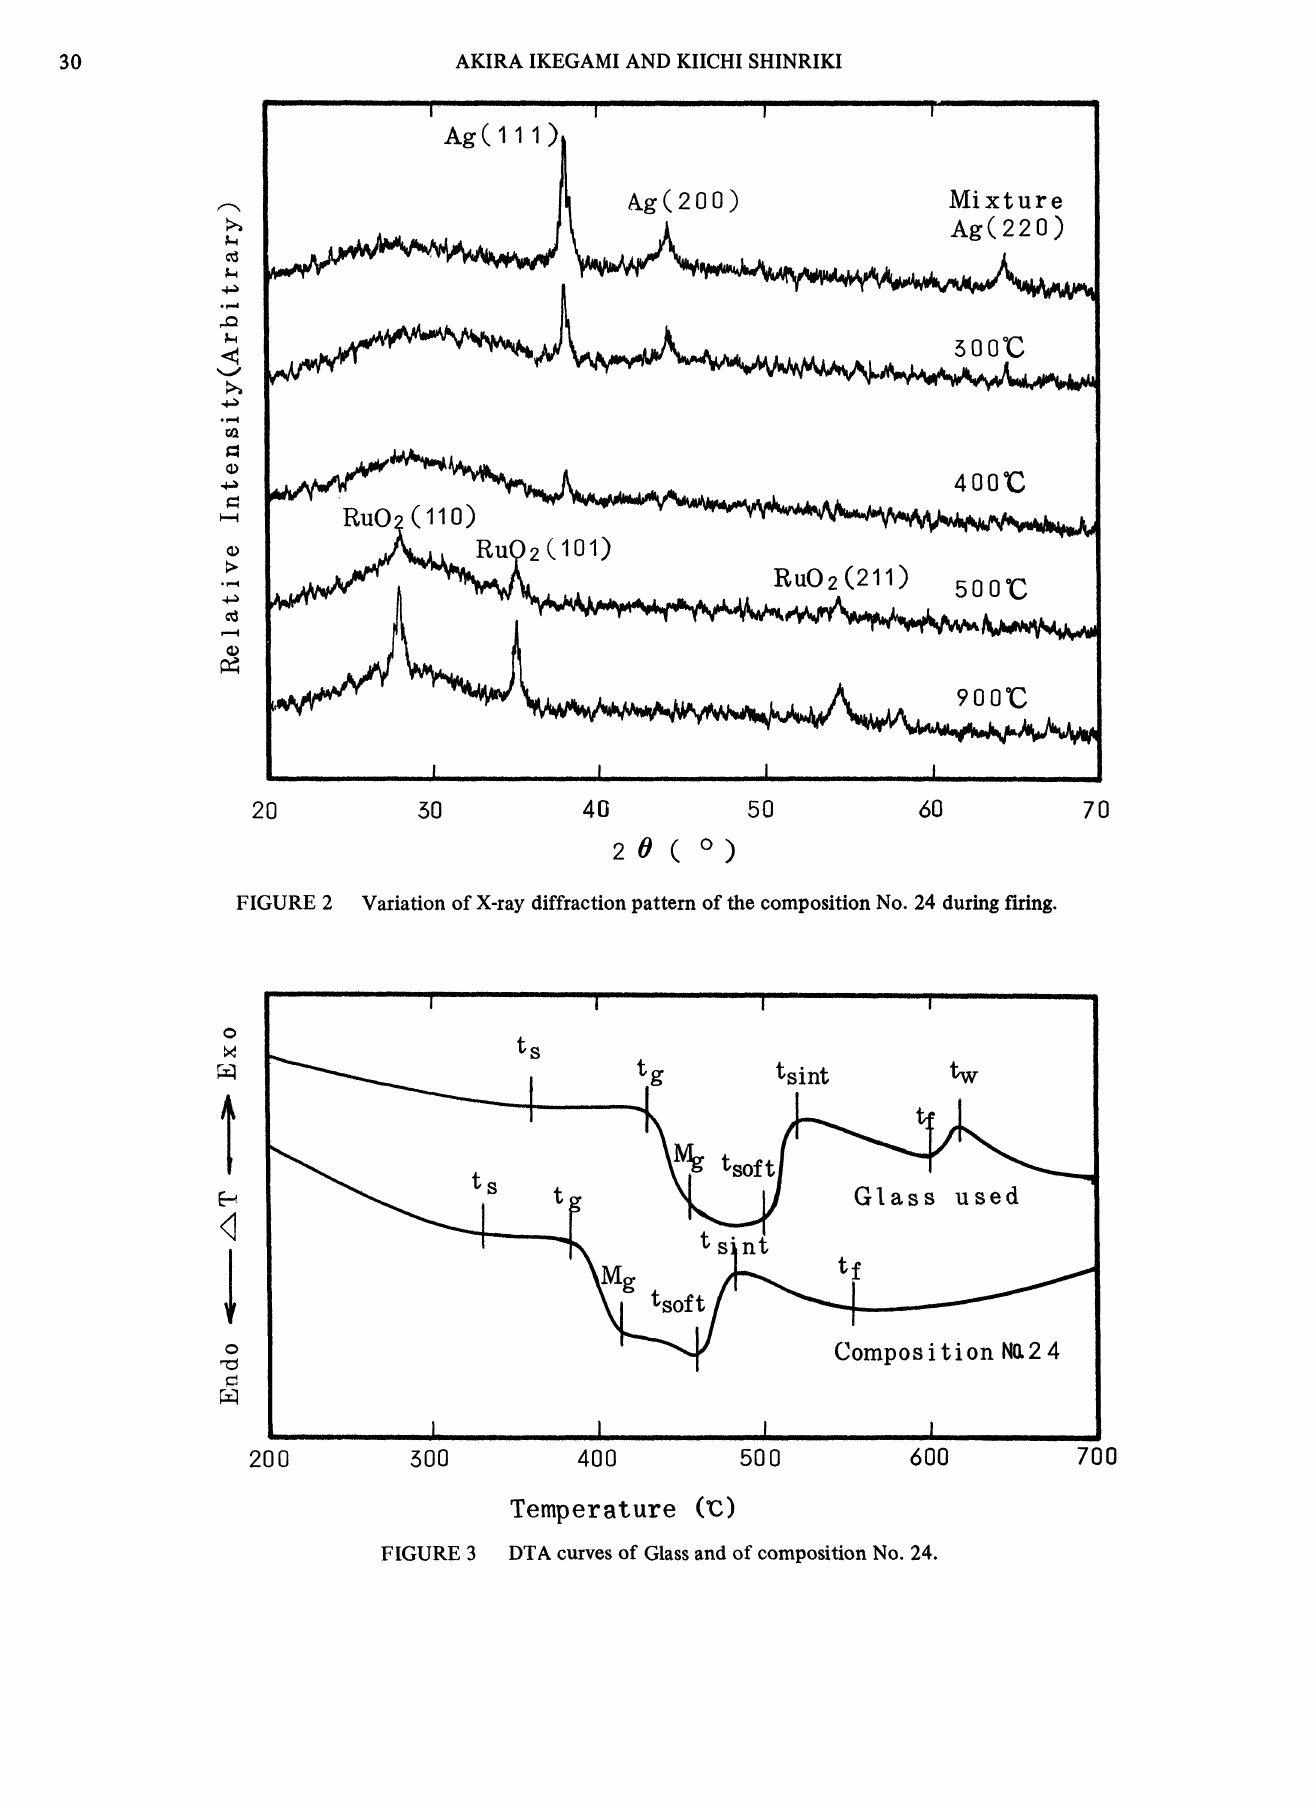
Temperature DTA curves of Glass and of composition No. FIGURE 3